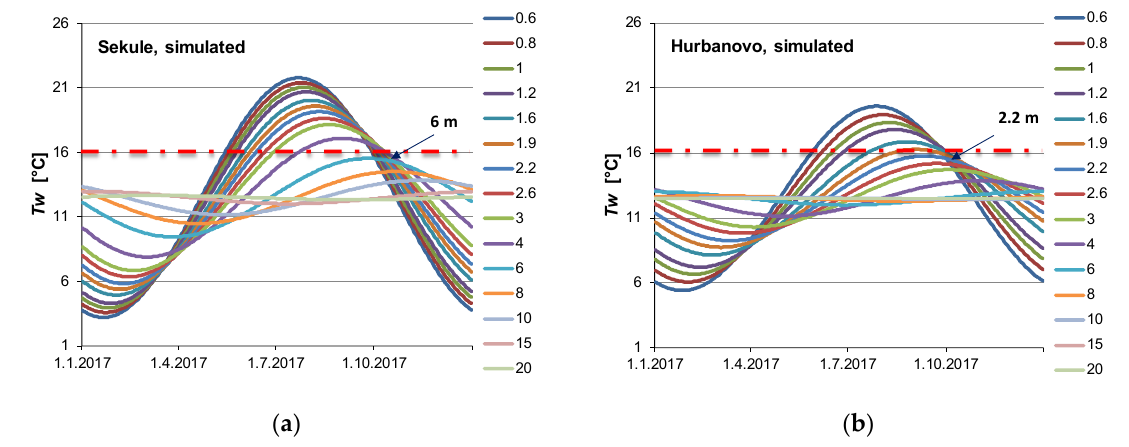
Figure 8. Simulated soil/groundwater temperatures at depths of 0.6–20 m at stations ( a ) Sekule and ( b ) Hurbanovo in 2017. Minimum depth where the groundwater temperature was less than 16 °C throughout the year at Sekule was 6 m, and at Hurbanovo it was 2.2 m.